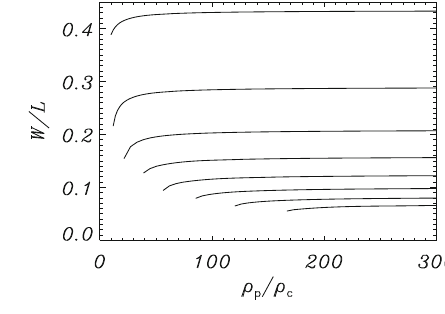
Fig. 87 Plot of the solution lines satisfying P 1 / 2 P 2 = constant in the parameter space. The upper line corresponds to P 1 / 2 P 2 = 1 . 25 and the lower one to P 1 / 2 P 2 = 3, with each line showing an increment in P 1 / 2 P 2 of 0.25 from the previous one. Image reproduced with permission from Díaz et al. (2010), copyright by